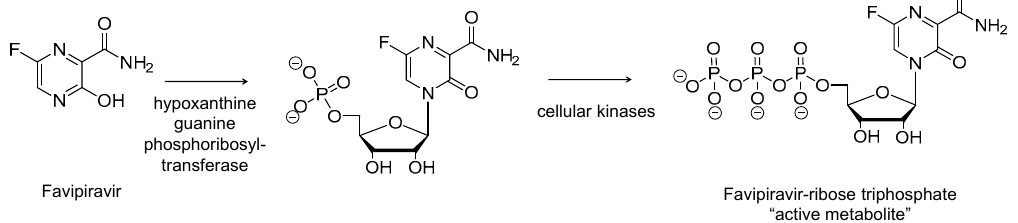
Figure 4. Chemical structure of favipiravir and its metabolic activation. Critical for its activation is the action of hypoxanthine guanine phosphoribosyl-transferase.